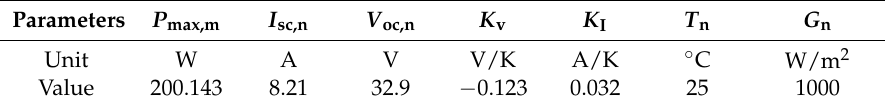
Table 4. One solar module profile (at 25 ◦ C and 1000 W/m 2